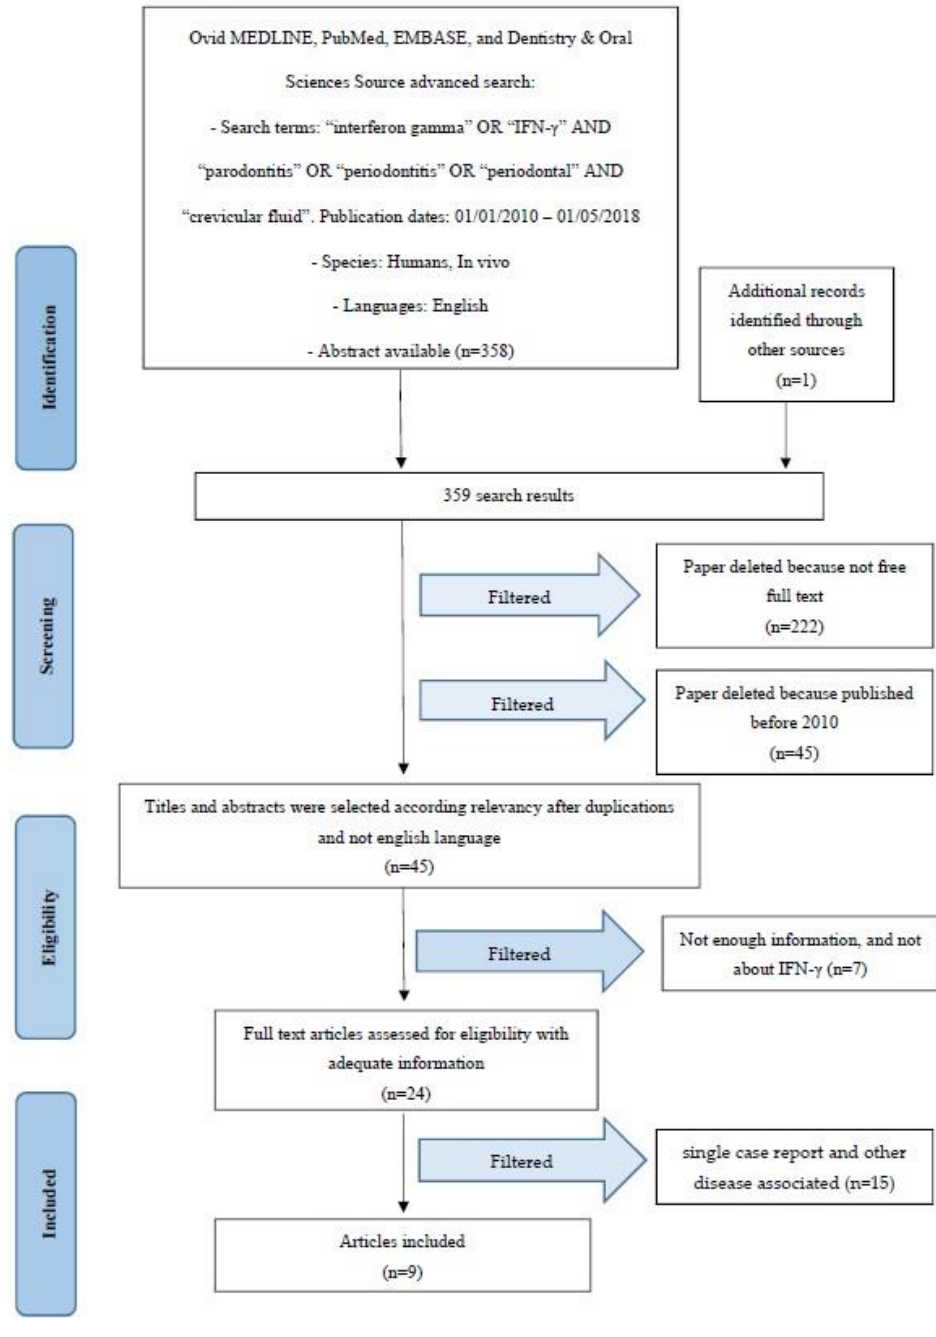
Figure 1. PRISMA flow diagram.